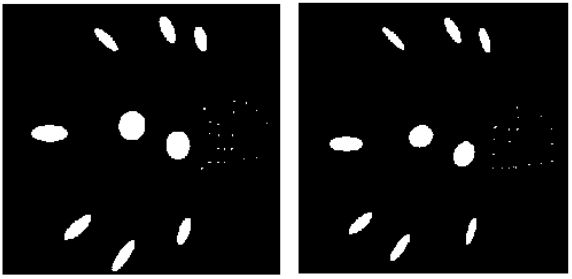
Figure 5. Camera station error ellipsoids for car door in scale of 700 before (left) and after (right) omission of improper images In the third investigation, 3D modeling of a plane nose was implemented (Amini, 2006). In this investigation, 26 images were captured and after bundle adjustment procedure, the standard deviation of exterior orientation values of each station was determined that are shown in Table 6.